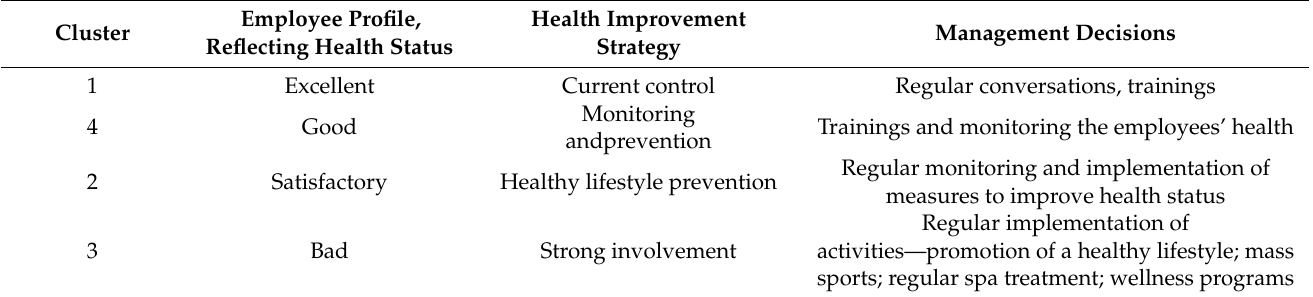
Table 8. Management decisions (strategies) for improving employee’s health quality by their groups.